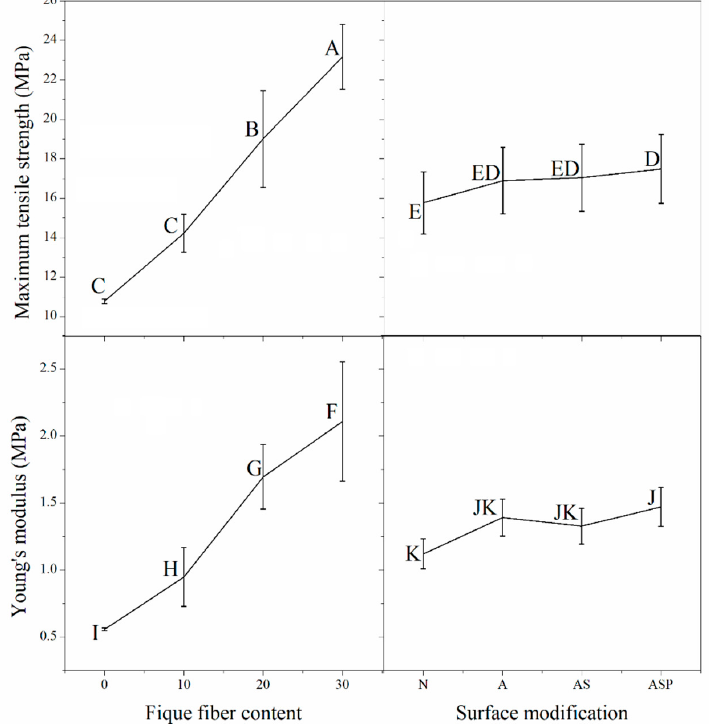
Figure 2. Principal effects for the maximum tensile strength and the Young’s modulus (According to the statistical analysis the values that do not share a letter are significantly